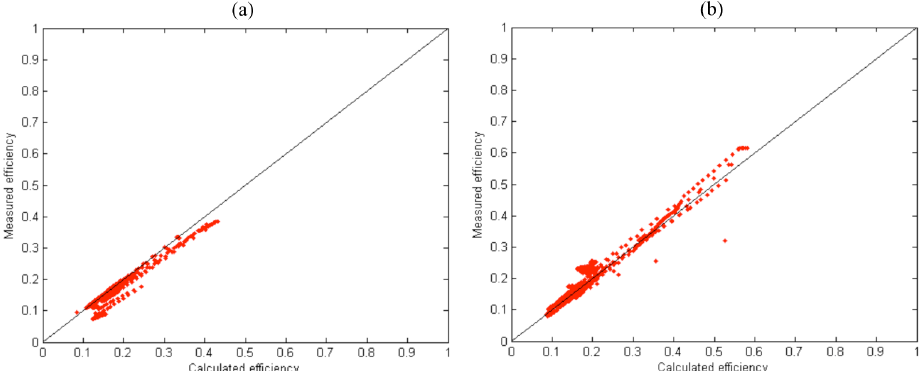
Fig. 4. Comparison between the calculated and measured thermal ef fi ciency: of (a) “ V ” -porous absorber plate and (b) “ U ” -corrugated absorber plate, on all four